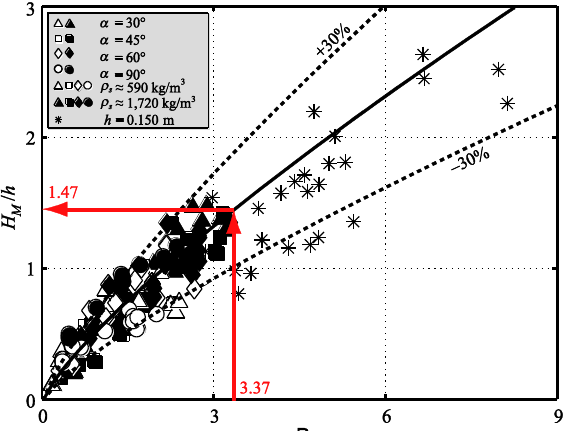
Figure 2. Example of prediction diagram based on P: Relative maximum wave height H / h versus P for granular slides and best fit H / h = (5/9)P 4/5 ( R 2 = 0.82, Table 1) with M M ±30% lines including most data points; the red arrows show the prediction for the 1958 Lituya Bay case resulting in H = 1.47 h = 179 m; data indicated with * are too low due to M non-negligible scale effects (adapted from Heller and Hager [26], with permission from © 2010 American Society of Civil Engineers).